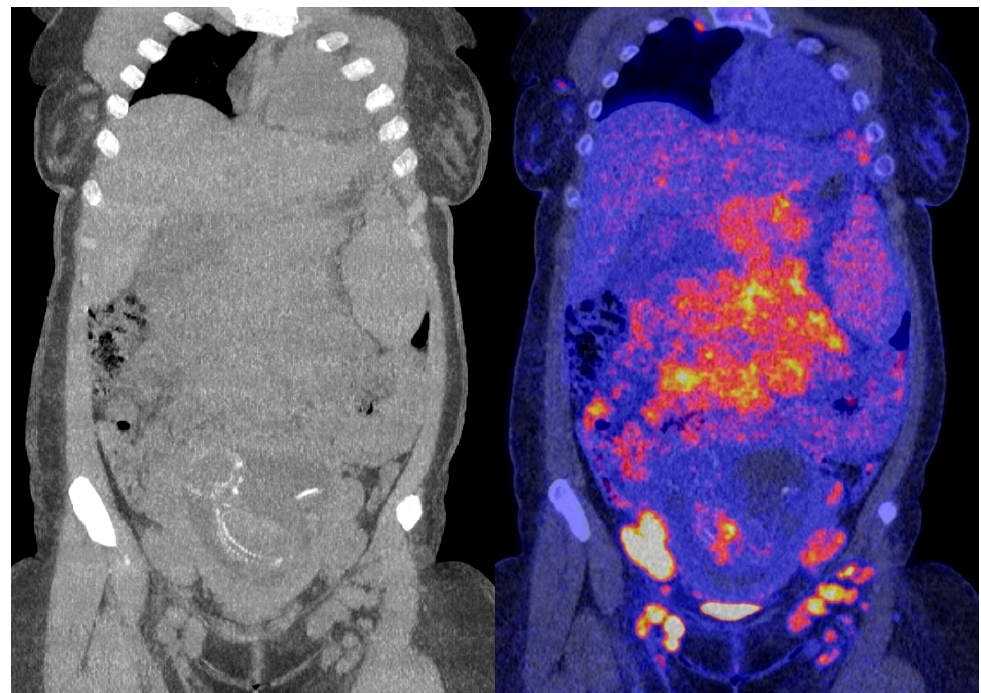
Figure 1. Maximum intensity projection PET images acquired with 170 MBq ( left ) and 34 MBq ( right ).